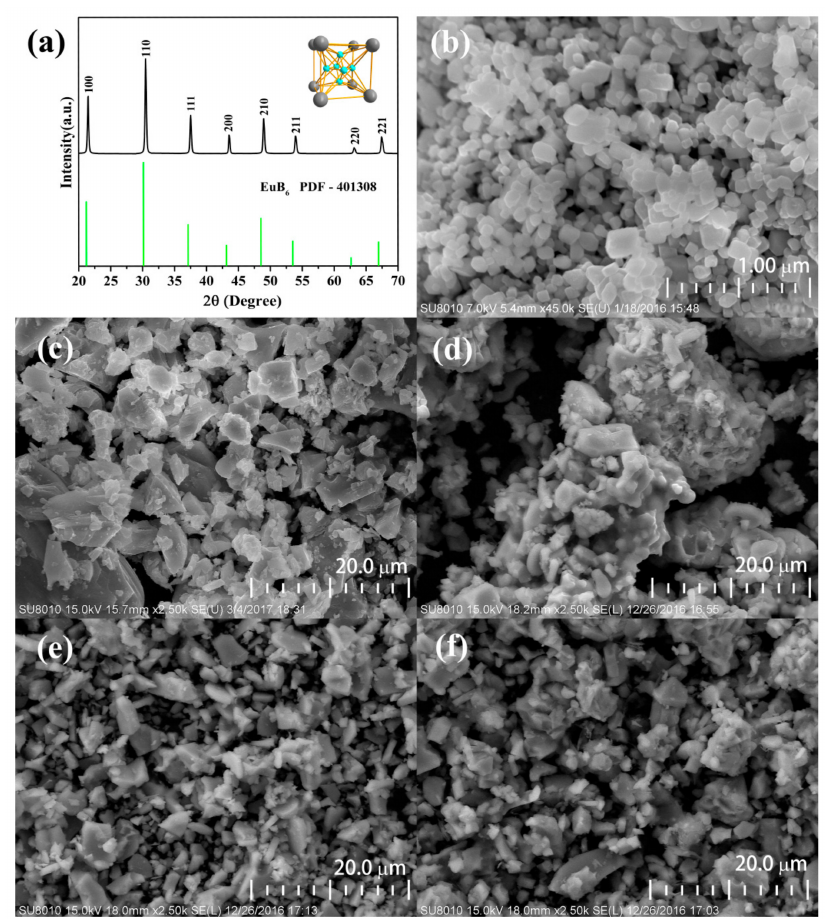
Figure 1. XRD patterns of ( a ) nano-EuB 6 and the SEM images of ( b ) nano-EuB 6 ; ( c ) CaSi alloys; ( d ) Ca 0.94 AlSiN 3 :0.06Eu 2+ @Eu 2 O 3 ; ( e ) Ca 0.94 AlSiN 3 :0.06Eu 2+ @EuN; and ( f ) Ca 0.94 AlSiN 3 :0.06Eu 2+ @EuB 6